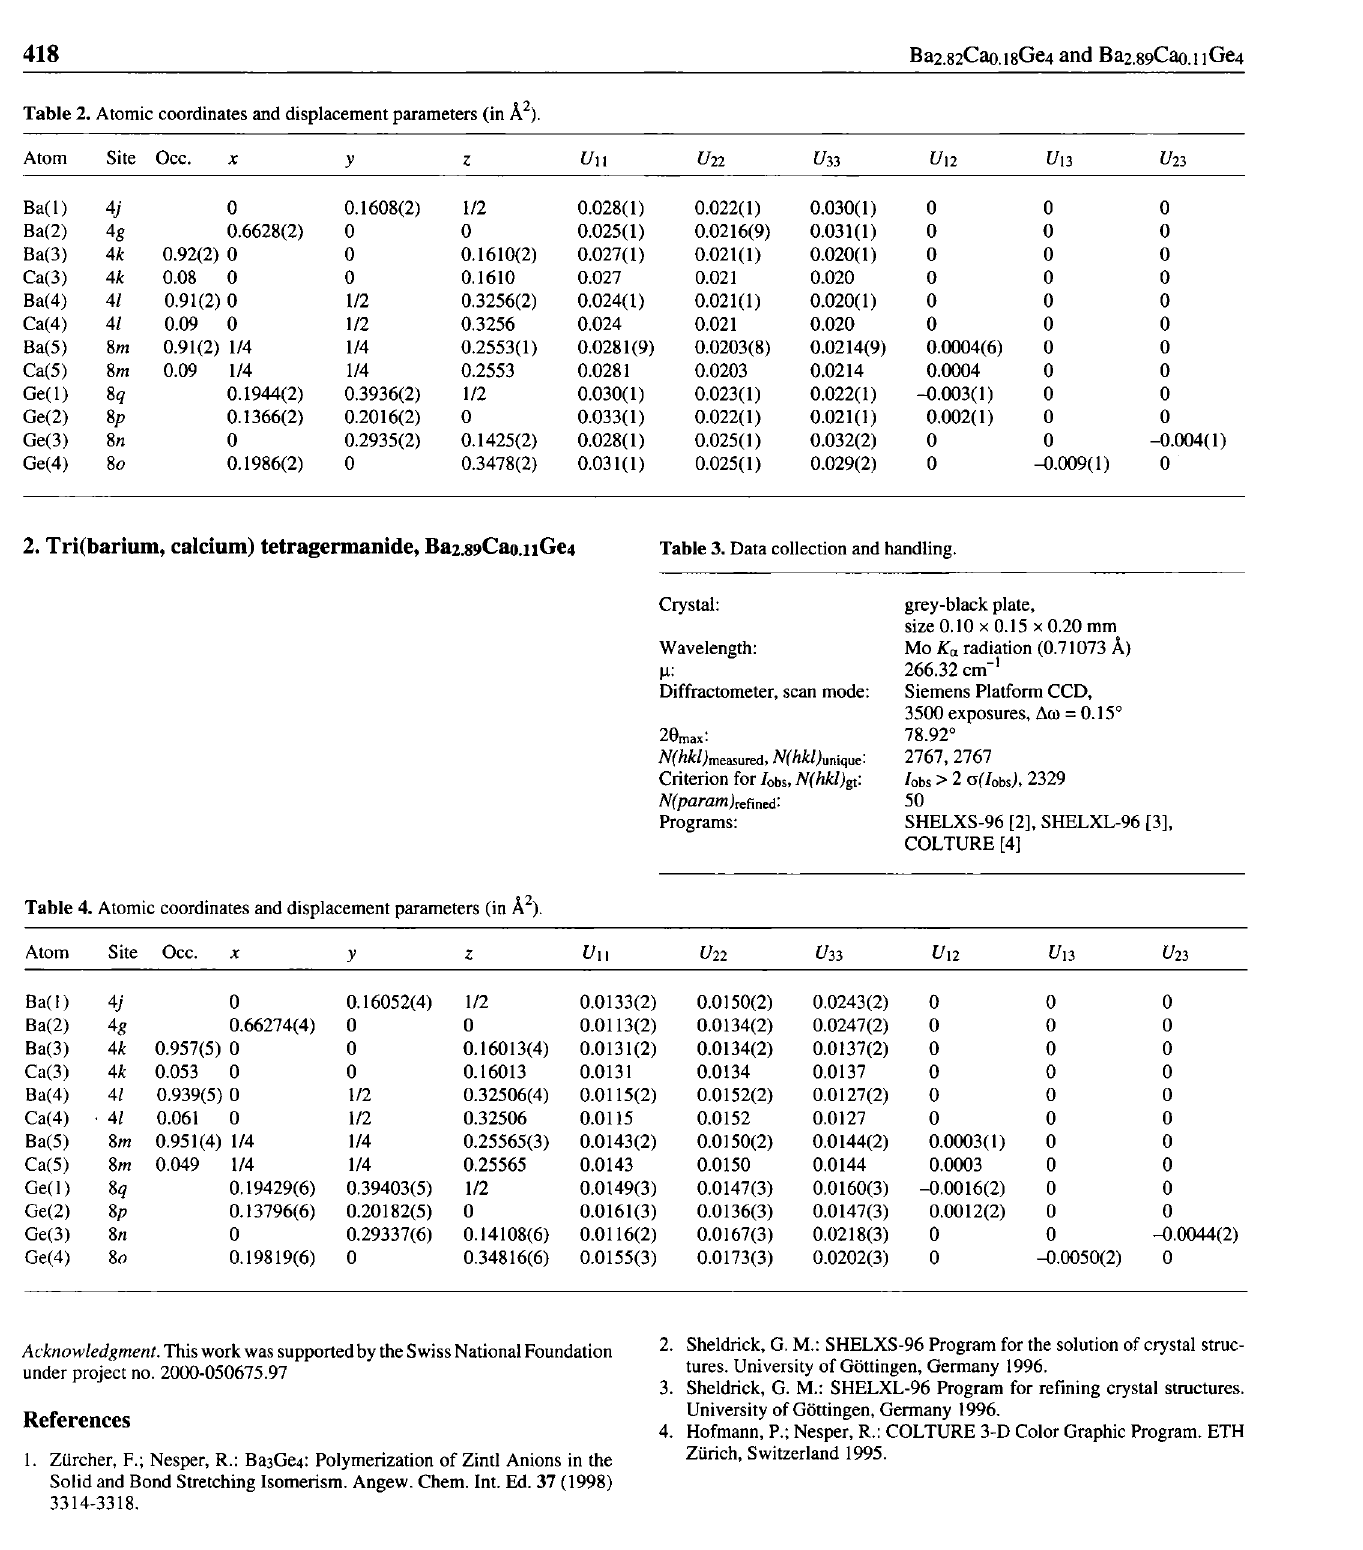
Table 2. Atomic coordinates and displacement parameters (in A 2 ).